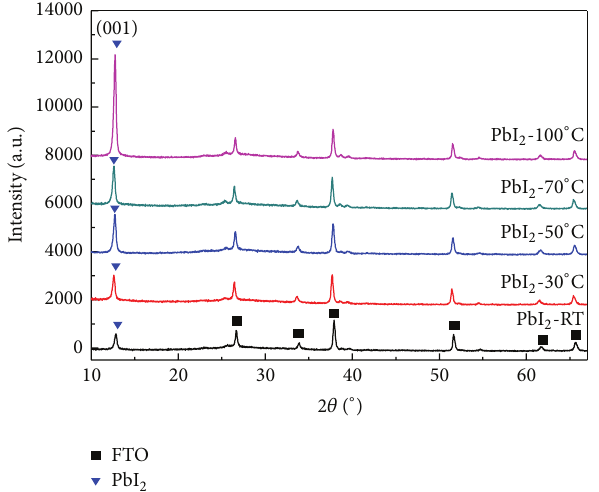
Figure 5: XRD patterns of MAPbI 3 films, where MAI was deposited on the top of the PbI 2 layers. The MAPbI 3 films depended on the different preheating substrate temperature of room temperature, 30 ∘ C, 50 ∘ C, 70 ∘ C, and 100 ∘ C,